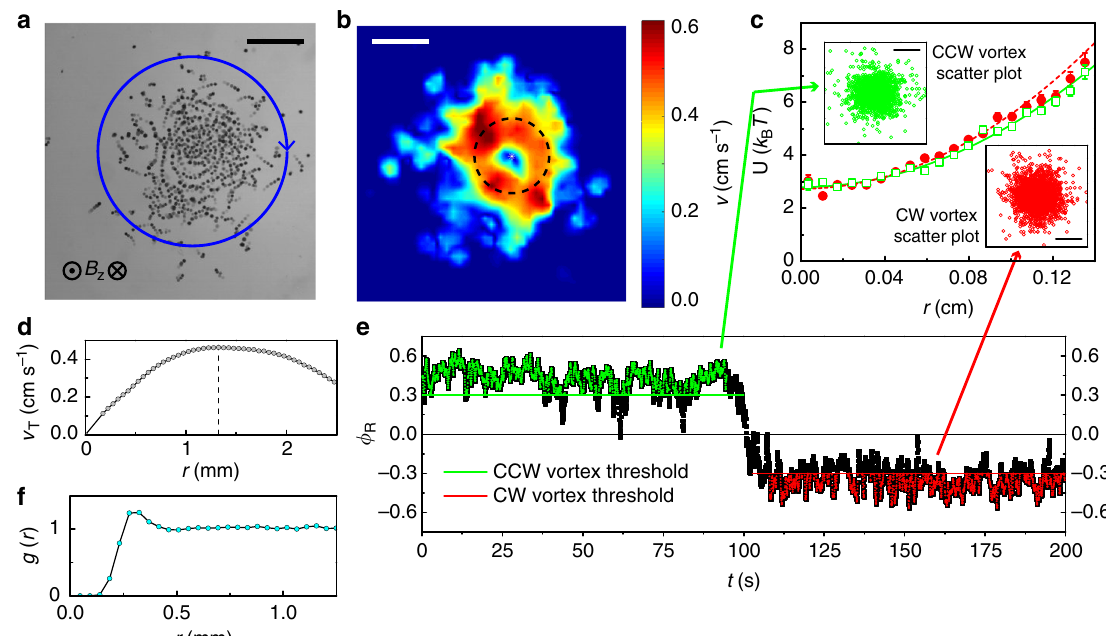
Fig. 1 A magnetic roller vortex. a An overlay of fi ve consecutive images showing a single roller vortex in a spherical potential well (radius of curvature 52 mm, rotating clockwise (CW). A particle grayscale intensity indicates time of the frame, light-colored particles being the initial frame and dark particles the fi nal (see Supplementary Movie 1). Scale bar length is 2 mm. b Calculated velocity amplitude fi eld. The white star symbol is the position of the vortex eye as determined by velocity and vorticity maps. Dashed circle around a vortex eye illustrates the core of the vortex as determined from the azimuthally averaged velocity pro fi le of the vortex shown in d . Scale bar is 2 mm. c Potential energy U of the vortex eye in the spherical well has a harmonic dependence on distance from center r . U was calculated using Eq. 1 from scatter plots of the vortex eye positions (insets). Scale bars are 1. Error bars are the standard deviation of the measurements. As indicated by the order parameter ϕ R in e the vortex spontaneously switched rotation direction during the course of the experiment. For scatter plots only frames with | ϕ R | > 0.3 were chosen. d Azimuthally averaged vortex tangential velocity pro fi le versus distance from the center for the vortex shown in b . Dashed line marks the boundary of the de fi ned vortex core where the rollers speed reaches maximum. e Time evolution of the polar order parameter ϕ R in a roller vortex demonstrating a spontaneous switch of the vortex chirality. f The pair correlation function for the rollers forming the vortex. g ( r ) has a single peak, implying the presence of a characteristic spacing between rollers. a – e The magnetic fi eld direction is aligned with the gravity and oscillates in- and out-of-plane (amplitude B 0 = 5.78 mT, frequency f B = 40